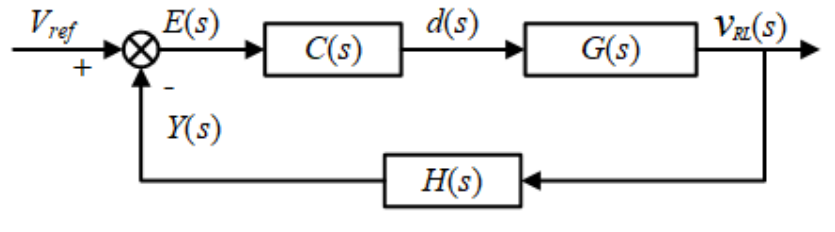
Figure 12. Reverse control loop diagram.